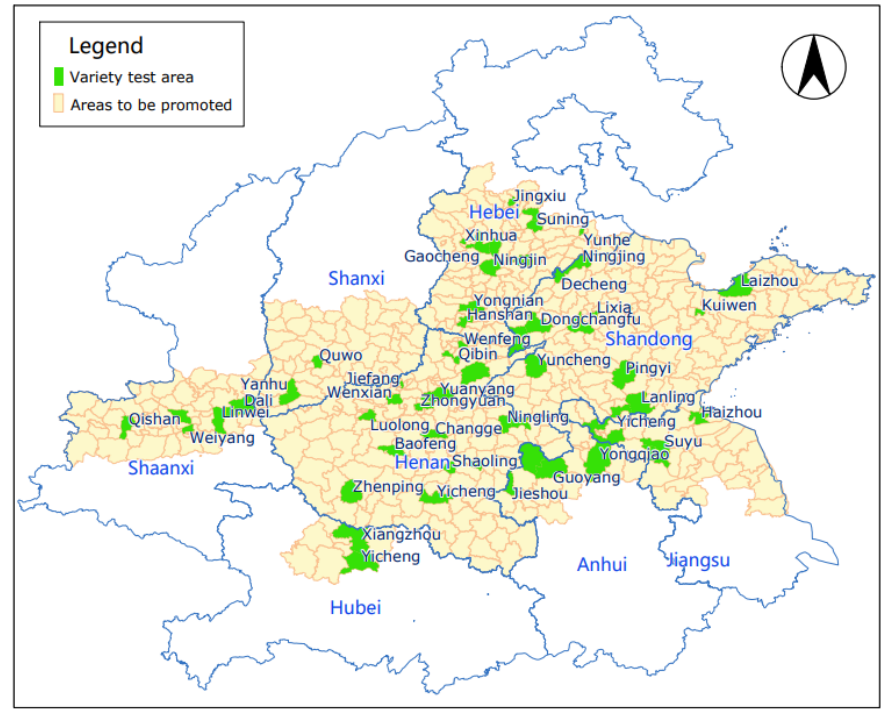
Figure 1. Graph of geographical area of Huang-Huai-Hai ecological region.